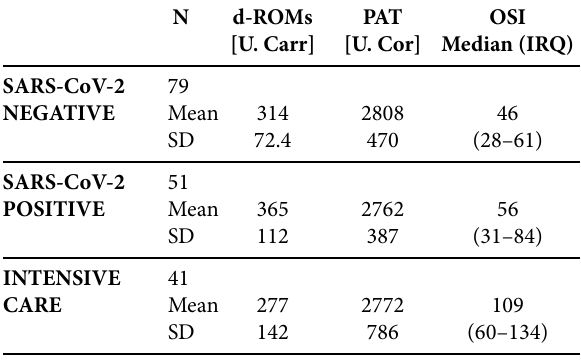
Table 1: Basic statistics of d-ROMs, PAT, and OSI